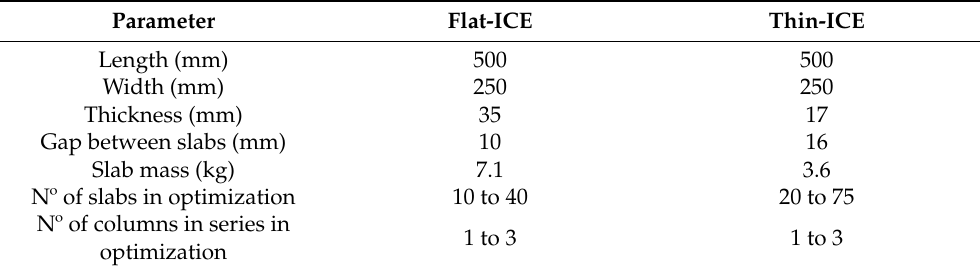
Table 3. Physical properties of PCM slabs and parameters used in the optimization.